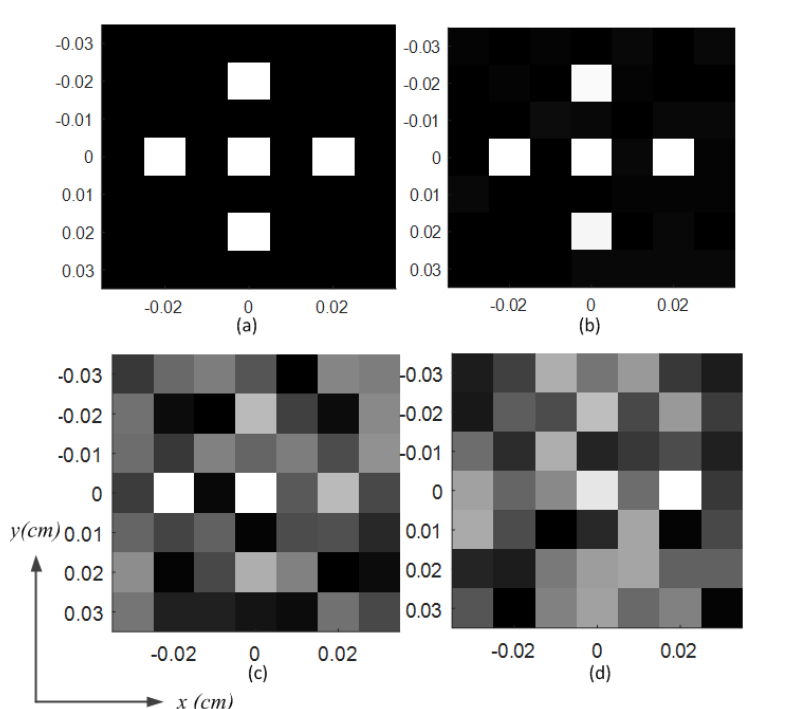
Figure 9. Comparisons of the imaging results; ( a ) origin image; ( b ) reconstructed image with a signal-to-noise ratio (SNR) of 20 dB; ( c ) reconstructed image with an SNR of 14 dB; ( d ) reconstructed image with an SNR of 8 dB.